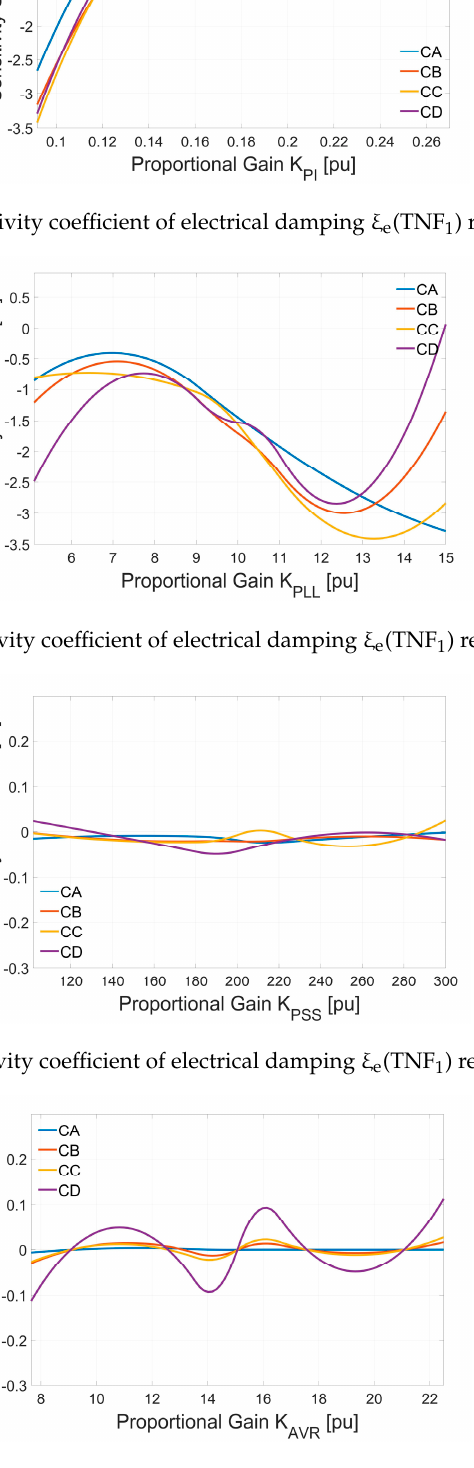
Figure 27. Sensitivity coe ffi cient of electrical damping ξ e (TNF 1 ) related to K PSS